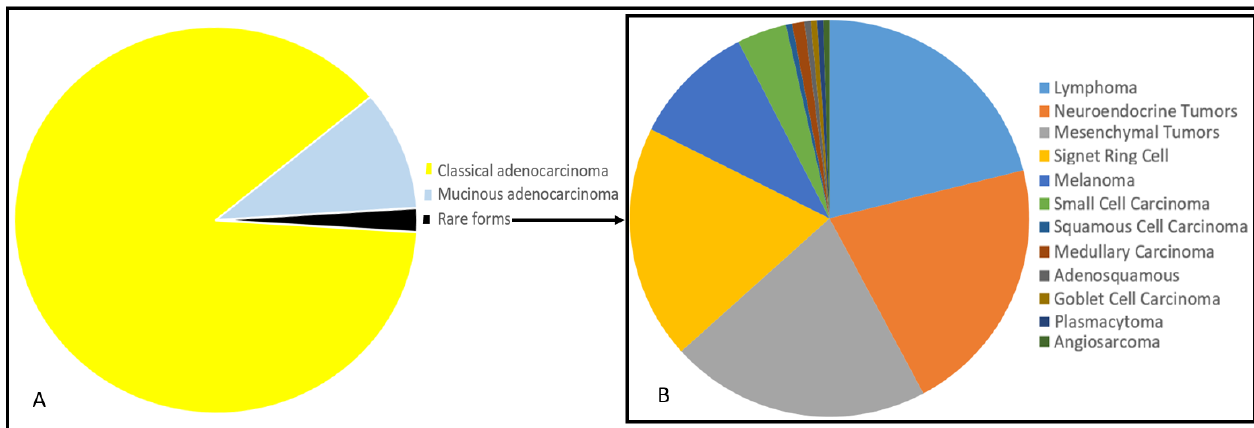
Figure 1. Representation of percentage of distribution of all colorectal cancers through pie chart (given a total frequency equal to 100) ( A ). Representation of percentage of distribution of rare forms of colorectal cancers (given a total frequency of rare forms equal to 100) ( B ). Different histotypes are indicated with colors in legends besides the pie charts. Data are extracted and elaborated from the American Cancer Society (Cancer Facts and Figures 2010. Atlanta: American Cancer Society; 2010).